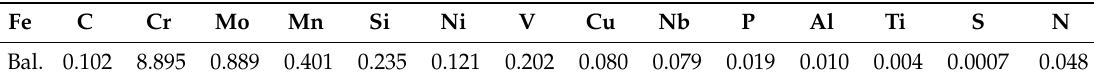
Table 1. The composition of the steel T91 as reported by the producer (wt. %). Fe